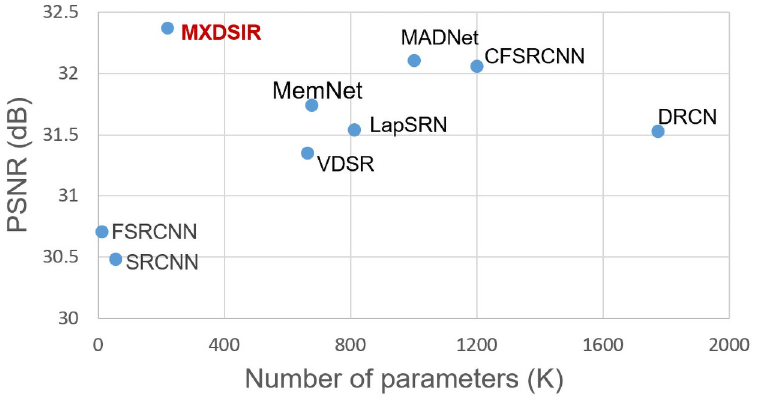
Fig 10. The performance comparison measurement on PSNR [81] versus the depth of the network (number of parameters). The performance results on the Set5 [84] dataset with scale factor 4 × .